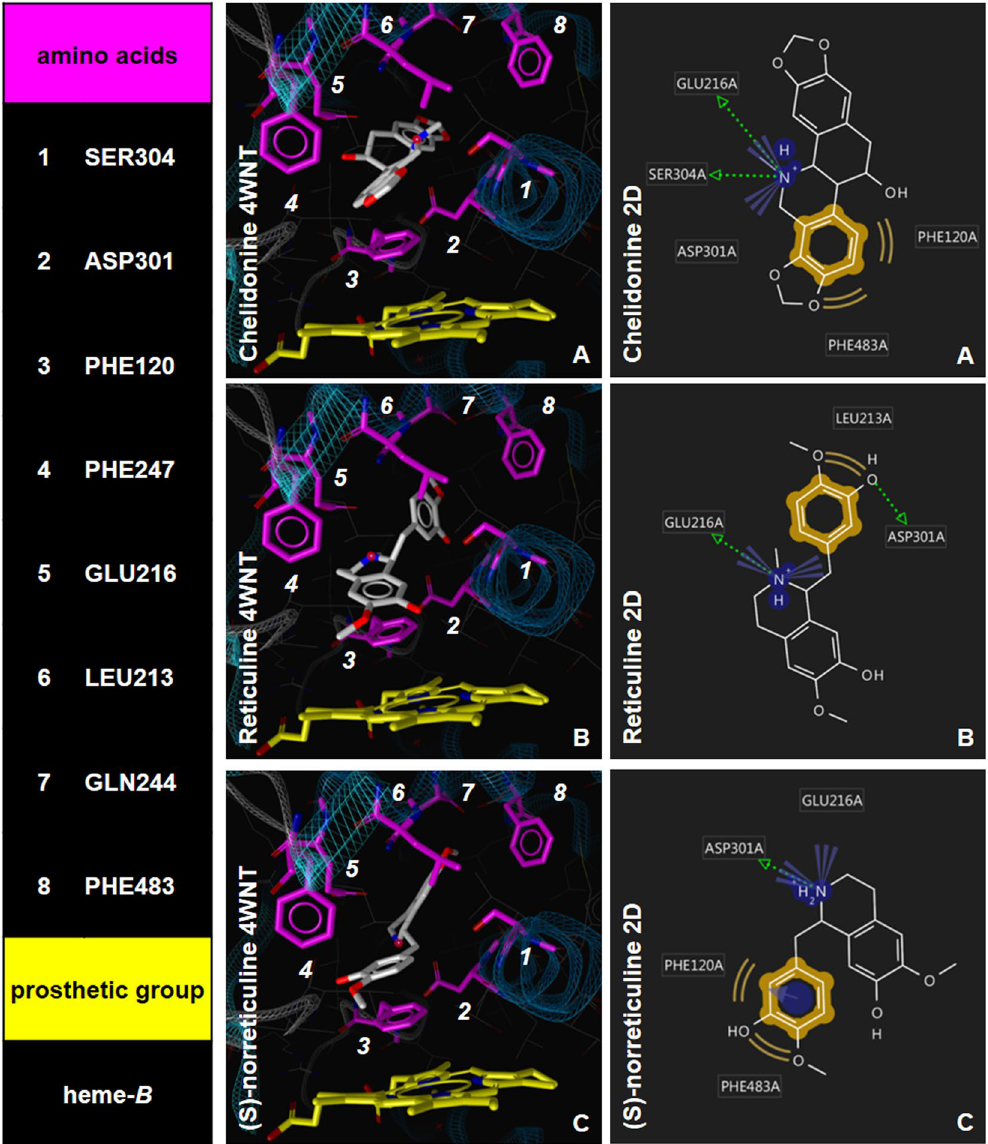
Figure 8. Visualization of the nanomolar CYP2D6 inhibitors 21 , 19 and 9 in the active site cavity ( A ), ( C ) and ( E ). The amino acids highlighted in magenta were found as important interaction and binding partners in previous studies. Heme-b as the prosthetic group is highlighted in yellow and coordinates an iron atom in the middle of the molecule that enables the oxidative metabolization of substrates. ( B ), ( D ) and ( F ) illustrate the 2D structures of the docked inhibitors and the respective interactions that are formed between the ligands and amino acids of the active site cavity of CYP2D6. Protein-ligand interactions are color-coded: green arrow - hydrogen bond donor, blue star - positively ionizable group, yellow - hydrophobic contact, blue circle with arrow - aromatic